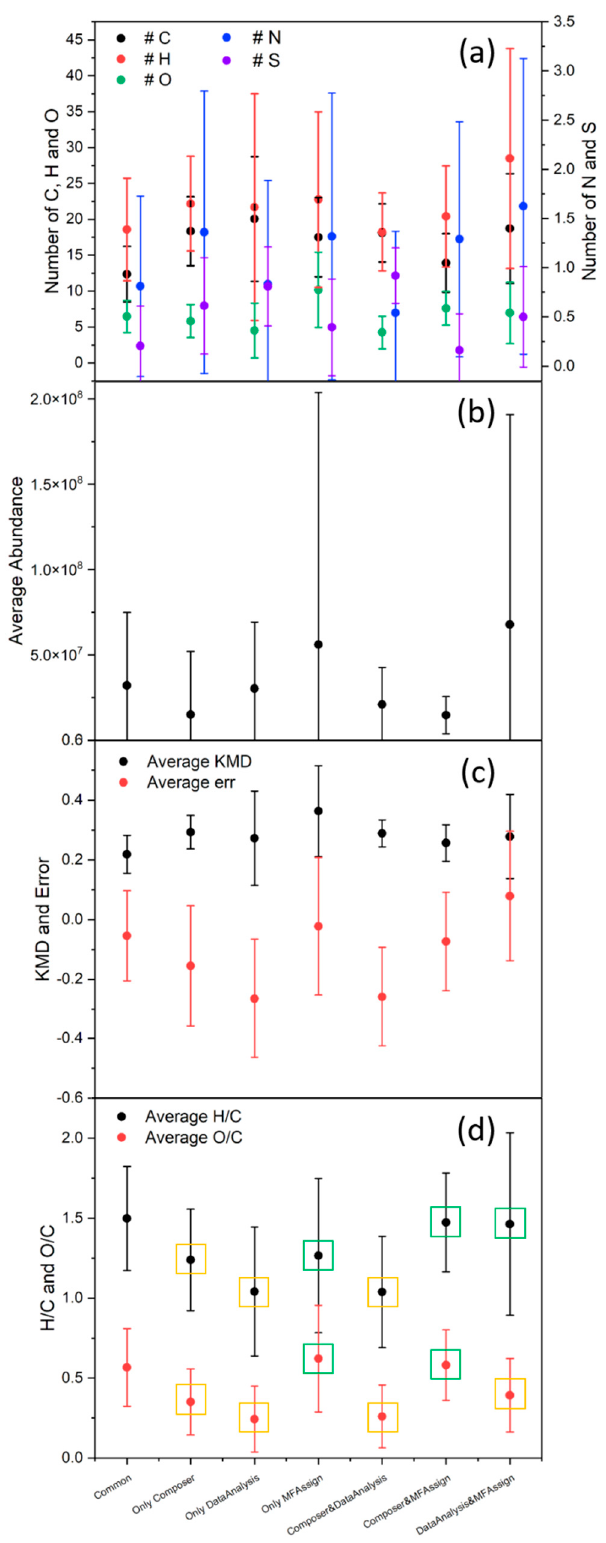
Figure 9. Comparison of ( a ) the number of atoms, ( b ) the average abundance, ( c ) the Kendrick mass defect (KMD) and error in the assignment, and ( d ) the H/C and O/C ratios for the seven fractions of the Venn diagram shown in Figure 6a. The error bars represent the standard deviations. In ( d ), the green square means that the value is not significantly different from “Common”, while the yellow square means that it is ( t -test, 0.05 threshold value).